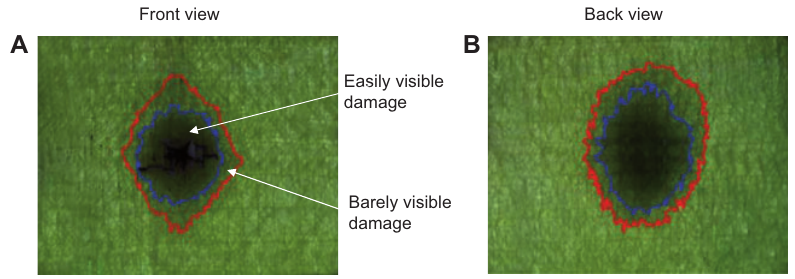
Figure 9 Damage zones in the specimen stricken by the pyramidal